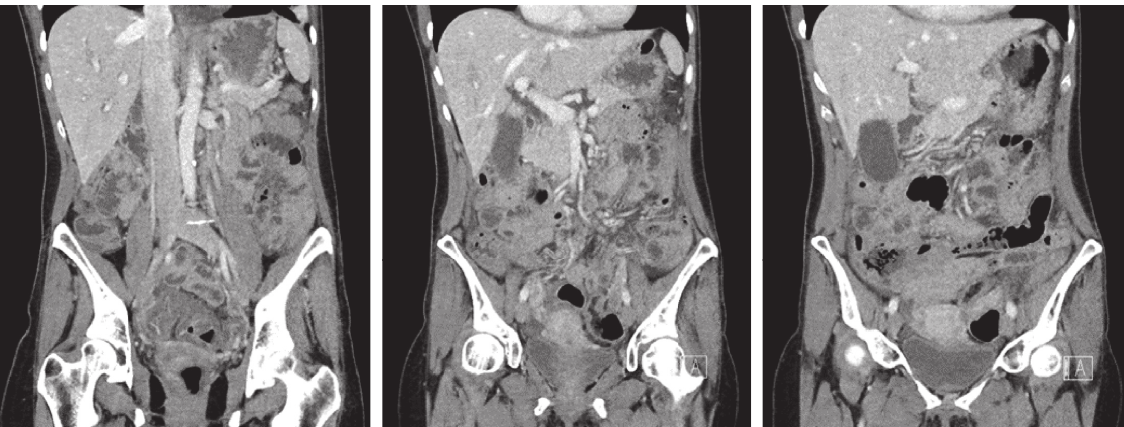
Figure 1: Computed tomography (CT) images demonstrated diffuse large bowel thickening consistent with ischemic